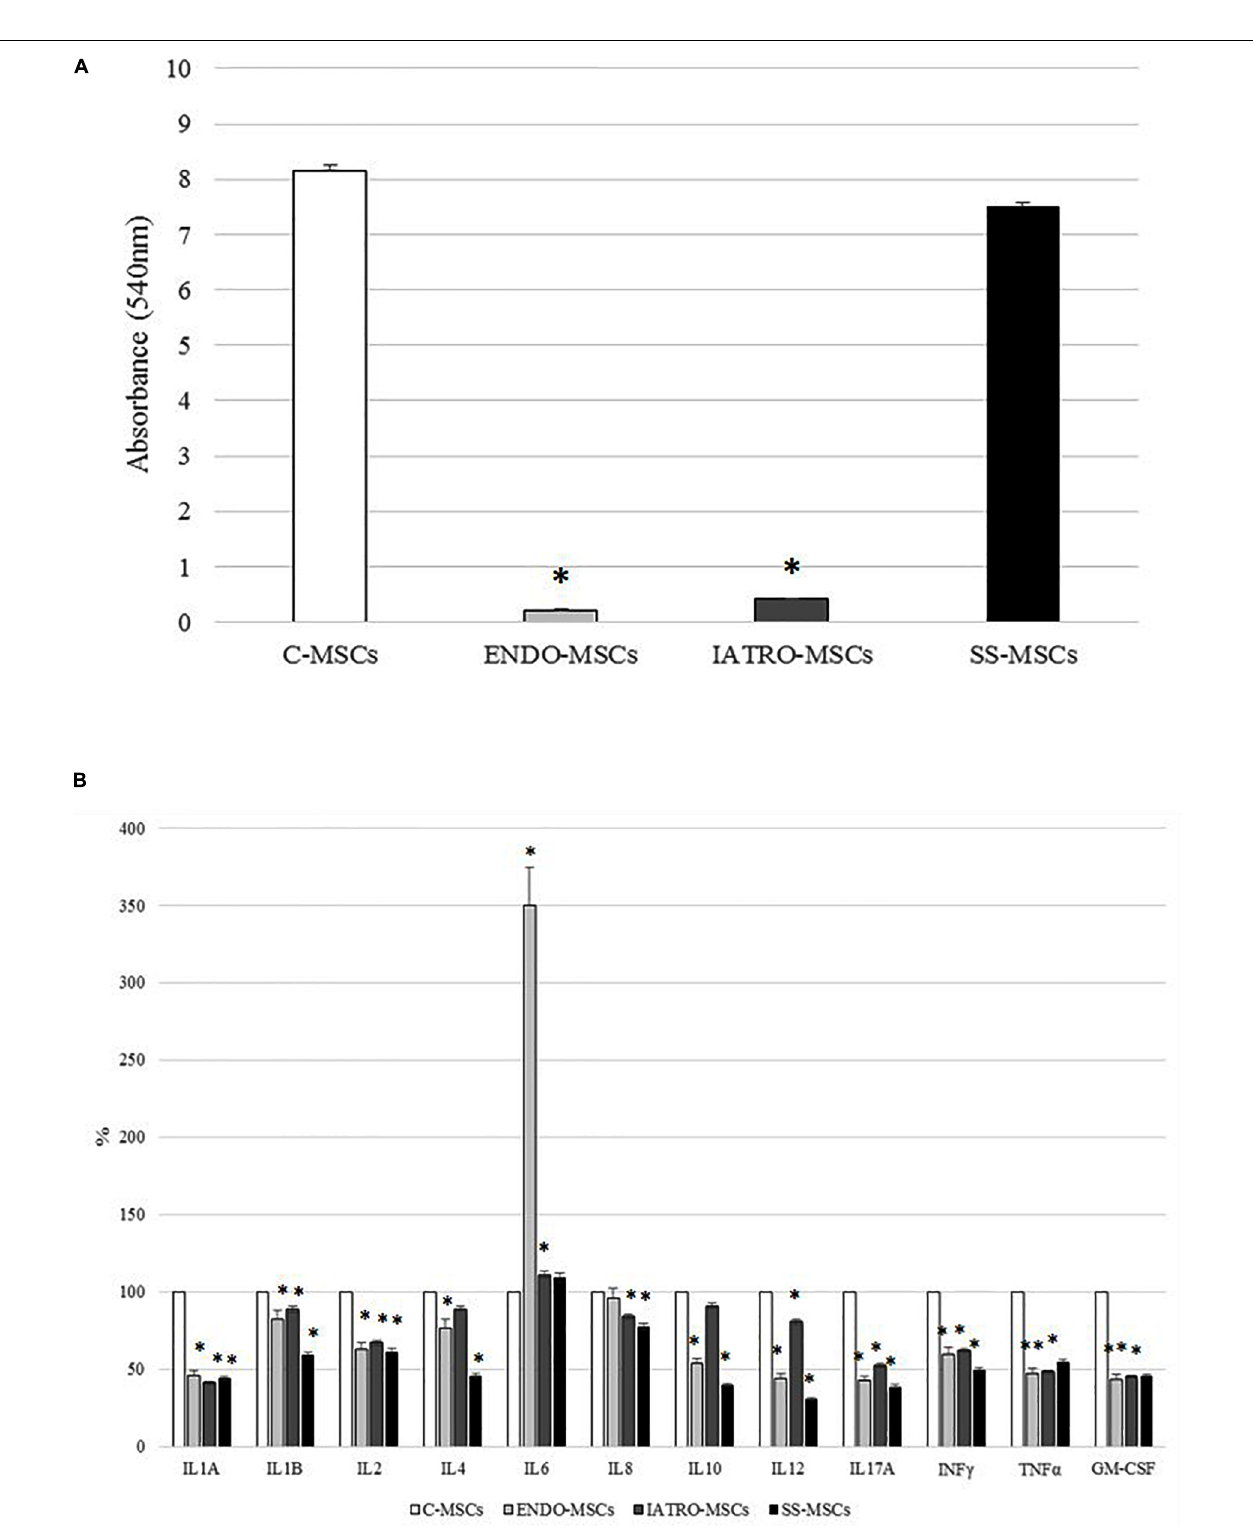
FIGURE 3 | Alizarin Red staining quantification and secretion of cytokines. (A) Quantification of the Alizarin Red staining by cetylpyridinium chloride. (B) Secretion of cytokines related to inflammation by ELISA test. The levels measured in C-MSCs were considered as 100% and those detected in MSCs derived from SC patients accordingly calculated; ∗ p < 0.05 MSCs from SC patients vs. C-MSCs.